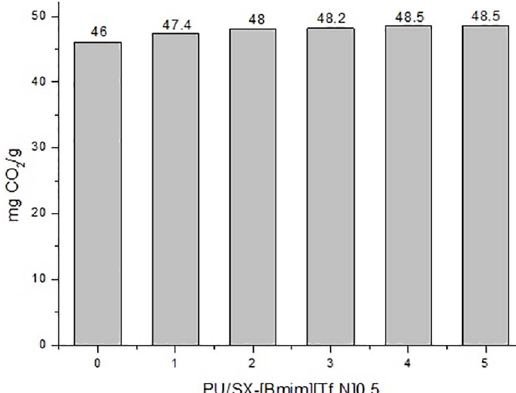
sorption/desorption tests for PU/SX-[Bmim] [TF Figure 9. CO 2